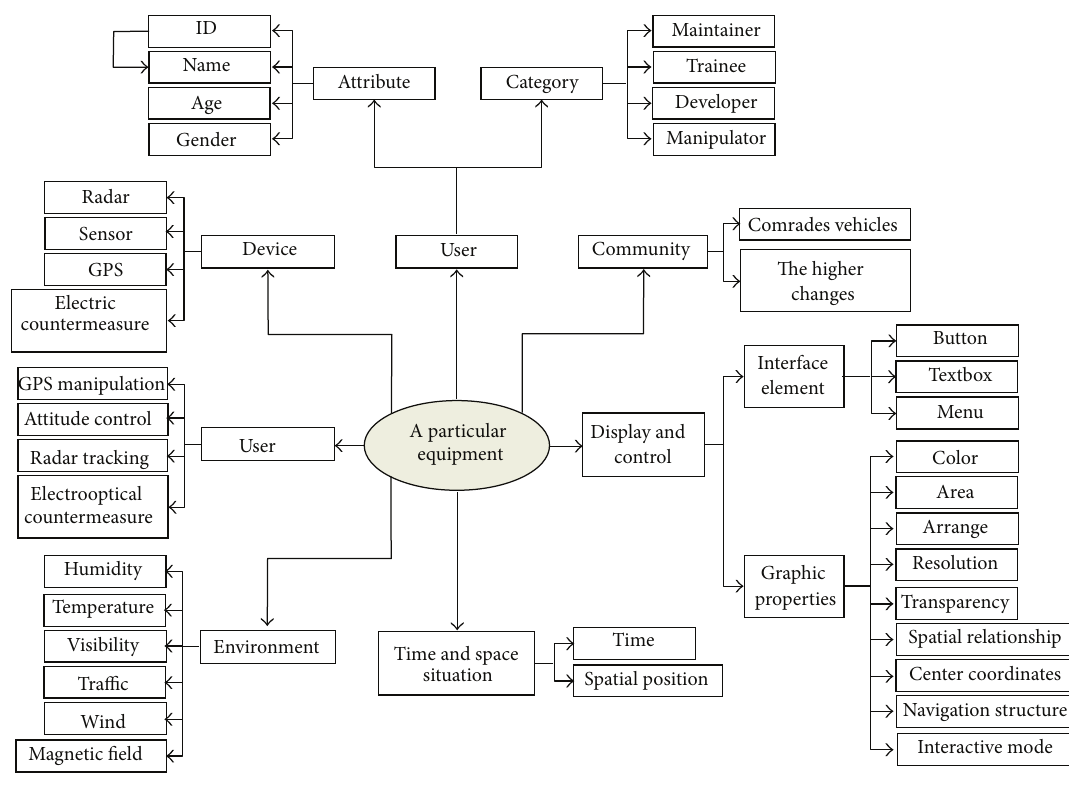
Figure 2: PT’s domain